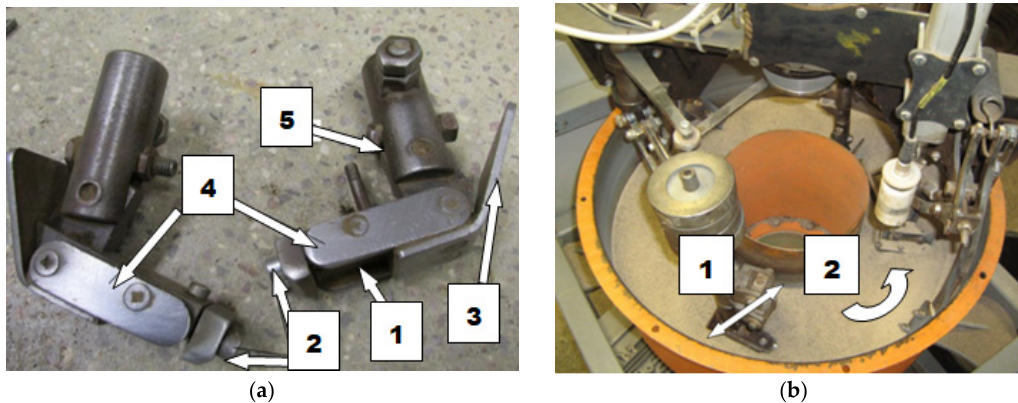
Figure 1. The “spinning bowl” type laboratory wear testing stand: ( a ) feet mounted on the stand arms with a designated place for sample fixing; (1) place of sample fixing, (2) screws holding the sample, (3) front skid, (4) side sample cover, (5) screw for changing the rake angles; ( b ) fragment of the stand during the operation; arrow (1) shows the direction of the sample movement, arrow (2) shows the direction of the bowl